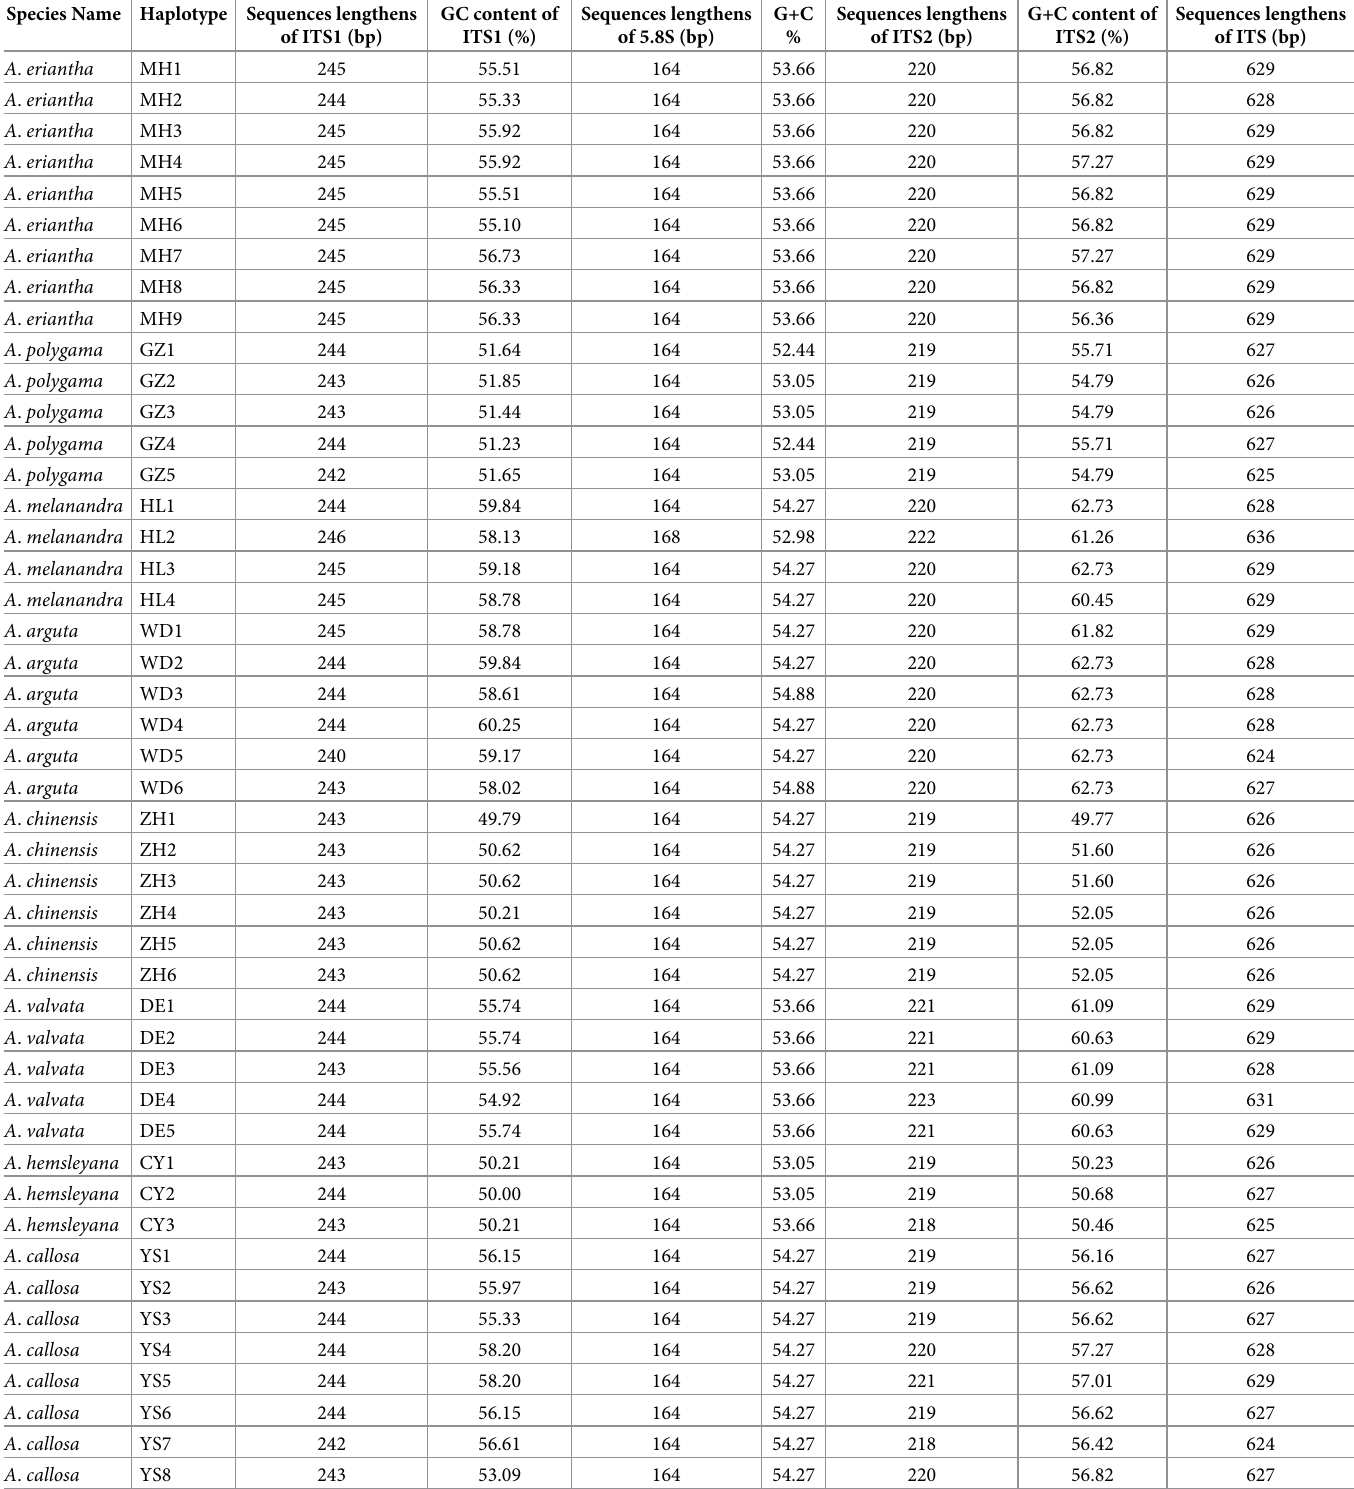
Table 2. Composition of ITS sequences of 8 Actinidia